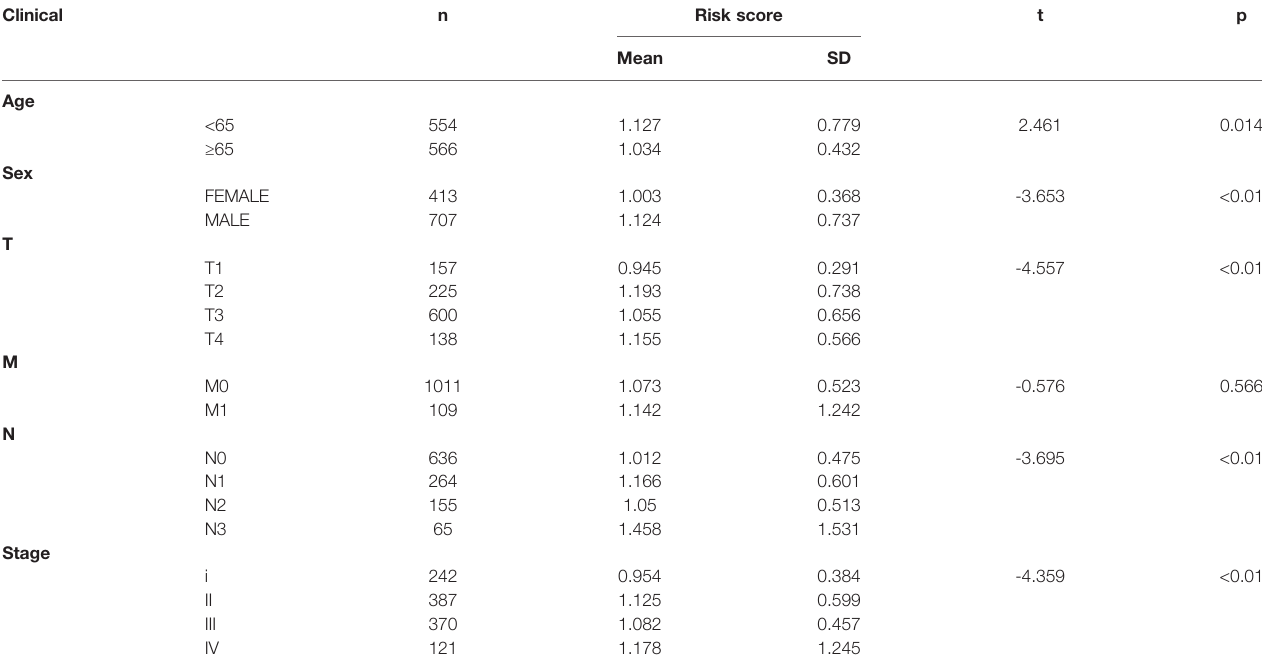
TABLE 2 | Clinical in fl uences of prognostic model in digestive system pan-cancer data.